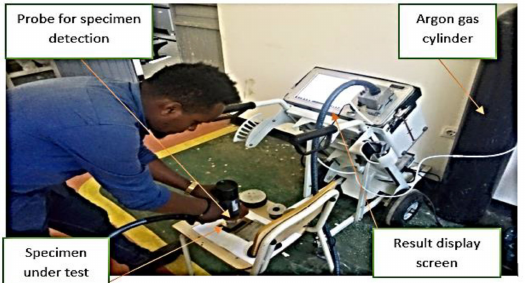
Figure 1. Setup ARC-MET8000 spectrometer (Ethiopian Technical